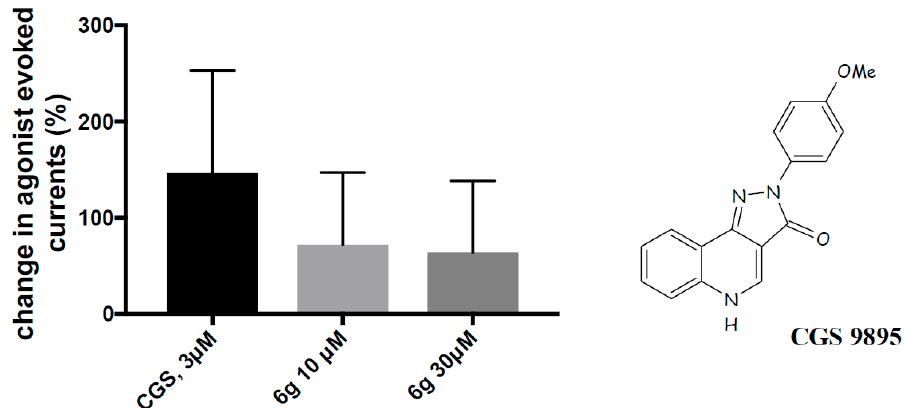
Figure 4. Compound 6g reduced the potentiation of GABA-induced Cl − currents by CGS 9895 (2-p-methoxyphenylpyrazolo[4,3-c]quinolin-3-(5H)-one) in Xenopus oocytes expressing recombinant α 1 β 2 GABA A receptors. Data are expressed as the percentage potentiation of the response induced by GABA at EC 5–10 values, and are the mean ± SEM of values obtained from three to six oocytes. The data obtained in GABA A receptors devoid of the γ subunit ( α 1 β 2 ) indicates that compound 6g reduces the potentiation of the GABA A receptor induced by CGS 9895 (10 μ M) (about − 58% at both 10 μ M and 30 μ M), suggesting that this compound binds the α +/ β− low-affinity site, too. This interesting result seems to suggest that our compounds acting as null modulators or antagonists could be selective α +/ β− low-affinity benzodiazepine binding site ligands. This hypothesis was